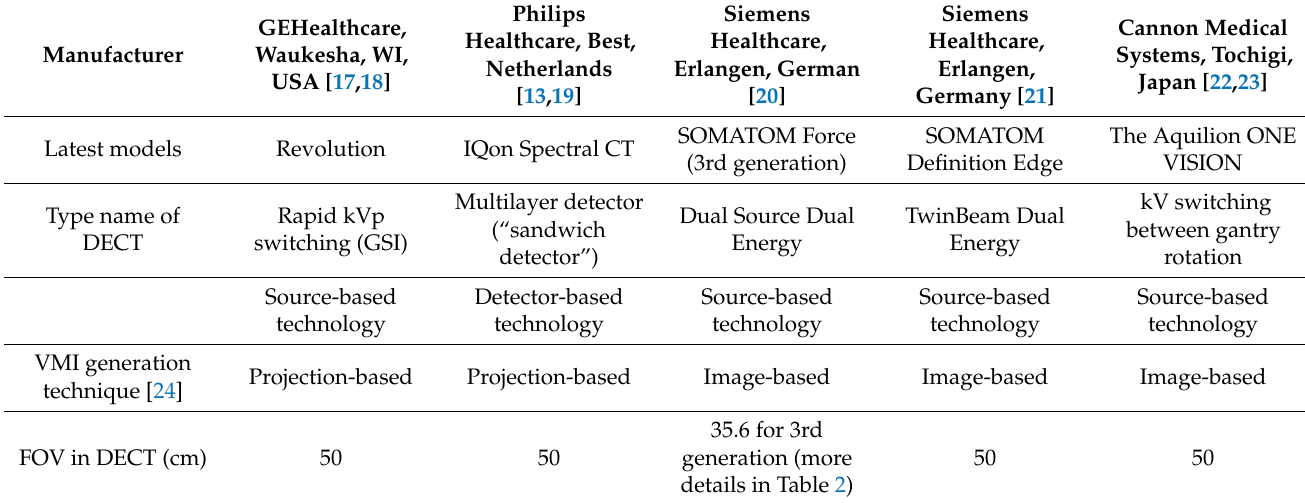
Table 1. Main differences between types of DECT and technical details of the latest models of each type. All types except dual-source offer 50 cm FOV.